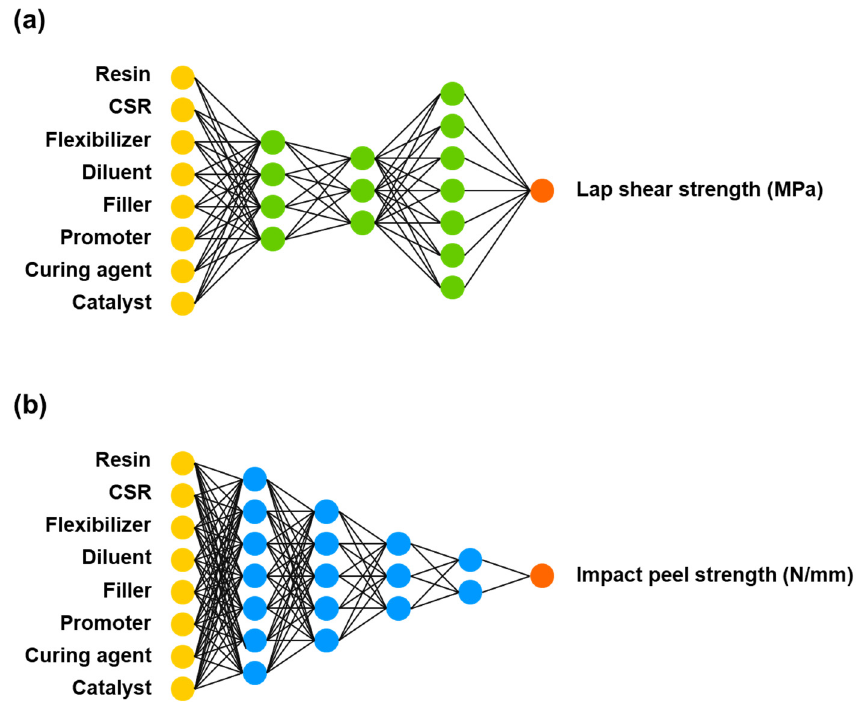
Figure 4. Artificial neural network (ANN) models for predicting ( a ) lap shear strength and ( b ) impact peel strength. Table 2. The root mean squared error (RMSE) and normalized squared error (NSE) of the training set and test set for predicting the lap shear strength and impact peel strength using the ANN model.